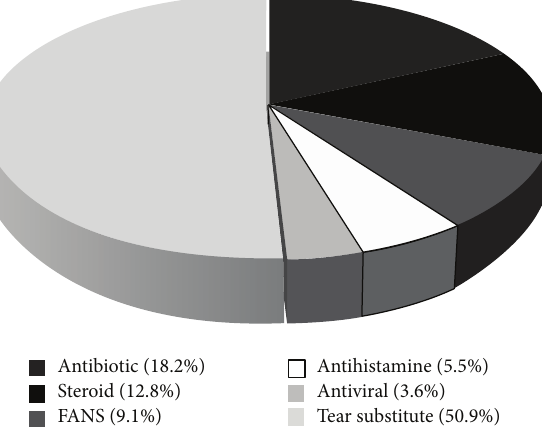
Figure 5: Percentage of subjects able and not able to self-administer eye drops by age group.